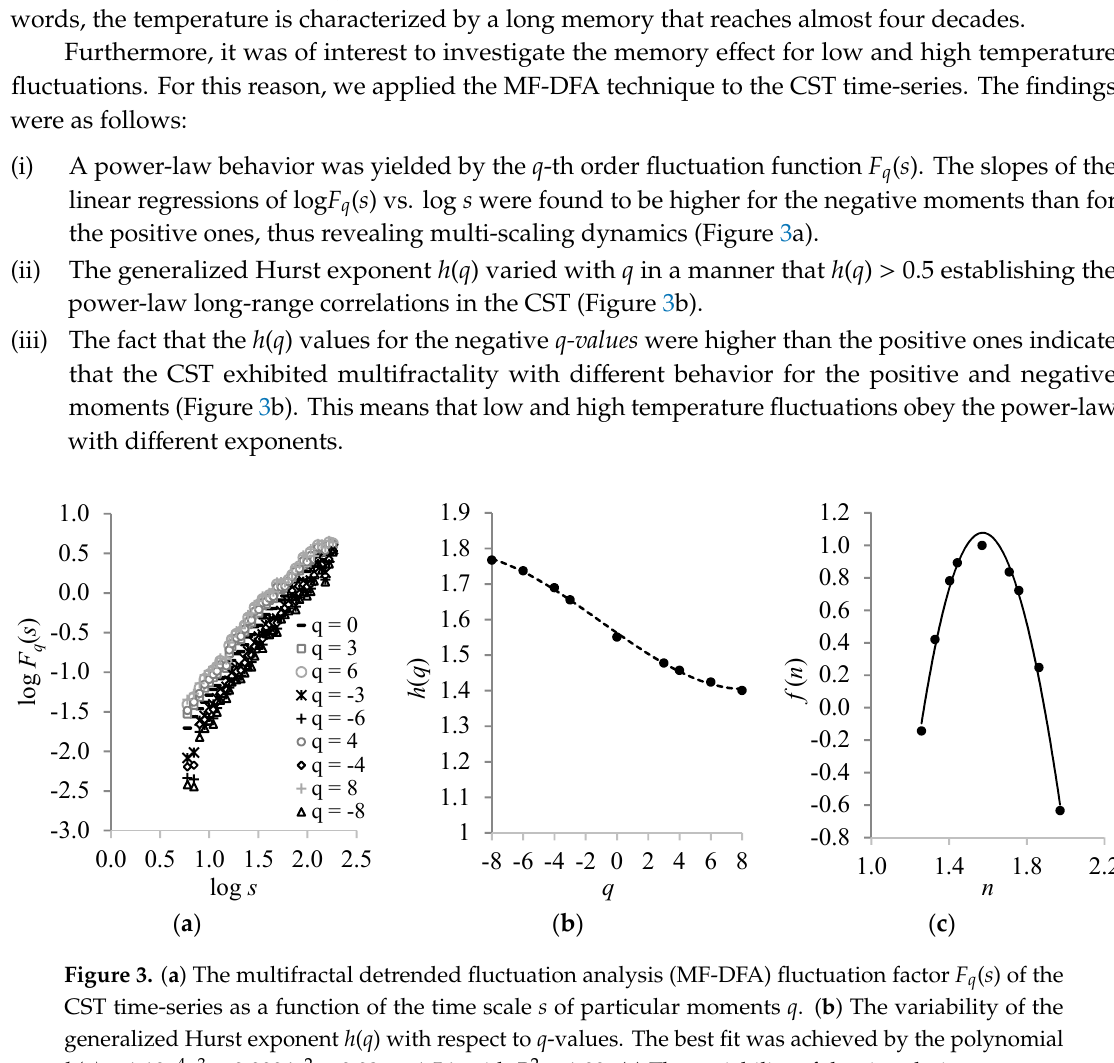
Figure 2. ( a ) The root-mean-square fluctuation function F d ( s ) of the CST time-series as a function of time scale s (in years). The corresponding best fit equation is y = 1.30x − 1.99 ( R ² = 0.98). ( b ) The variability of the power-law exponent expressed as local slopes of the log F d ( s ) vs. log s calculated within a window of 12 points (circles) and 10 points (crosses). The dashed grey line represents the 2 s a intervals around the local slopes with an average value of 𝑎 ̅ = 1.2. ( c ) The power spectral density as a function of frequency (a) (dashed gray line) with a power-law fit (black line) ( y = 1·10 − 7 ·x − 2.24 with R ² = 0.56) and the exponential fit (grey line) ( y = 7·10 − 5 ·e –11.5x with R ² = 0.39).